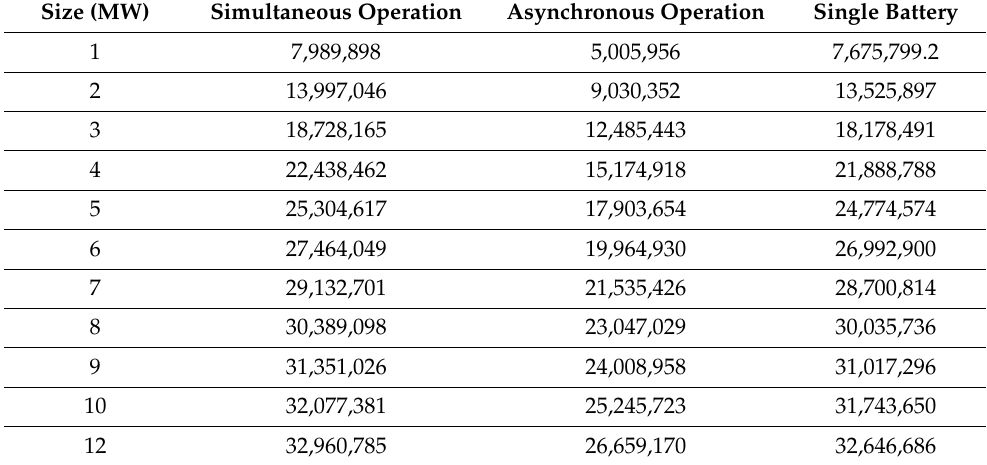
Table 2. Operation benefit of BESS integrated wind farm (in Ethiopian birr (ETB)) with various BESS capacities in different operating strategies.